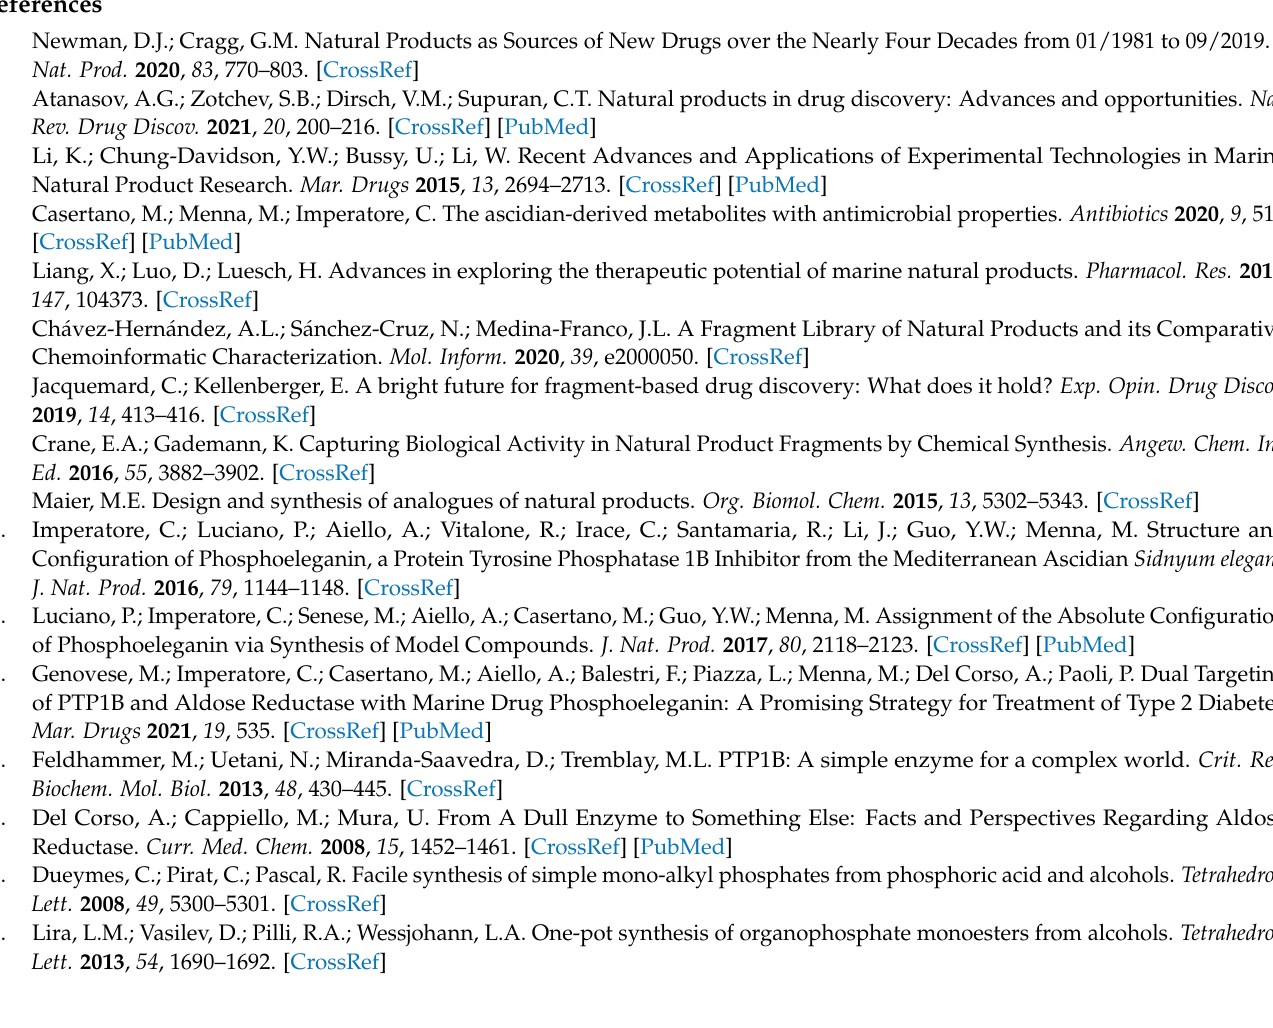
compound 9b ; Figure S36. HR-ESIMS spectrum of compound 9b ; Table S1. Effects of compounds 2